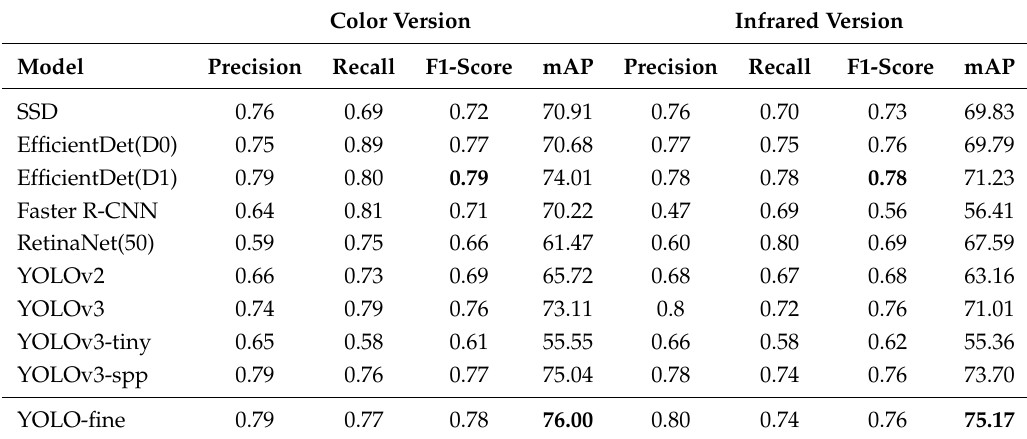
Table 5. Detection results on VEDAI1024 color and infrared versions. The best results of F1-score and mean average precision in